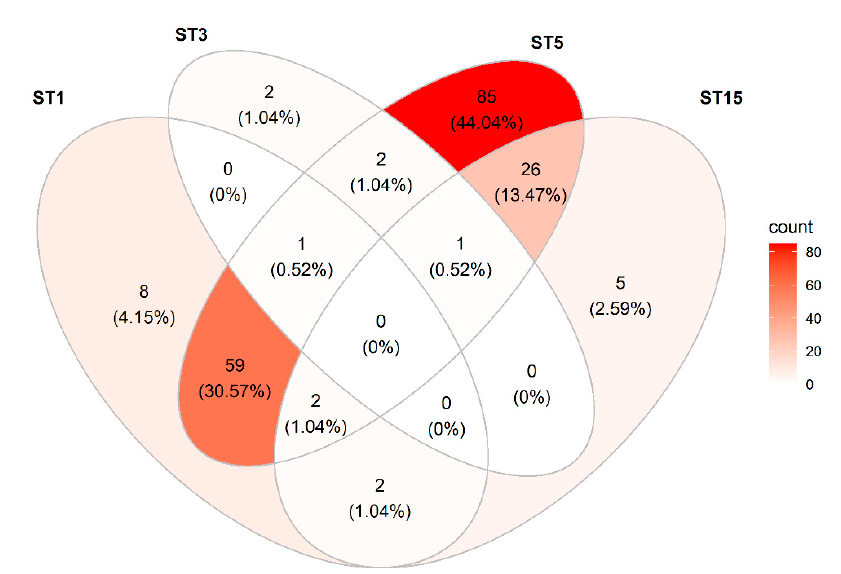
Figure 2. Venn diagram showing the distribution and co-occurrence of Blastocystis sp. subtypes detected in the study of fecal DNAs from pigs from four different herds in